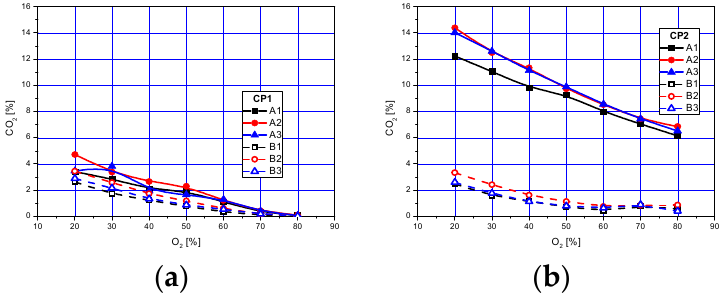
Figure 5. Changes in averaged values of molar fractions of CO 2 in the planes CP1 ( a ) and CP2 ( b ) with respect to oxygen concentration for variants A1 , A2 , A3 , B1 , B2 , B3 .